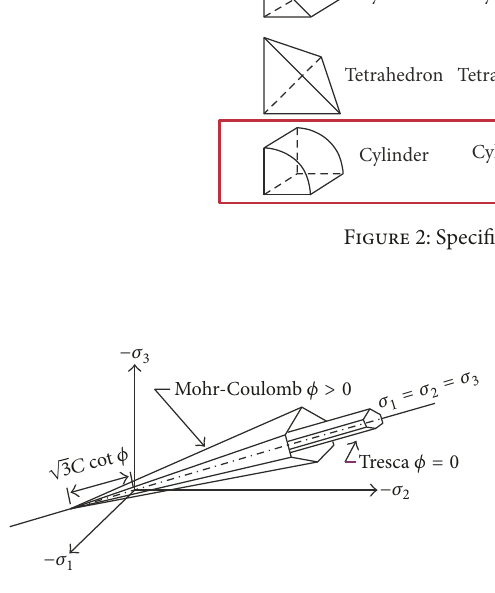
Figure 3: Mohr-Coulomb material model used to investigate the nonlinear soil behavior